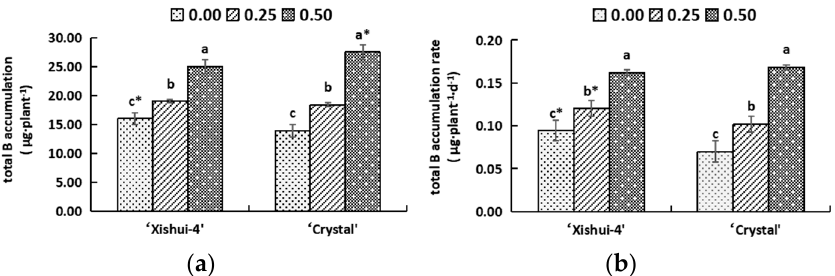
Figure 4. Effects of B-deficiency on B accumulation of two grape genotypes: ( a ) total B accumulation; ( b ) total B accumulation rate. Different lowercase letters within each column are significantly different at p < 0.05 between treatments. * is significantly different at p < 0.05 between genotypes.